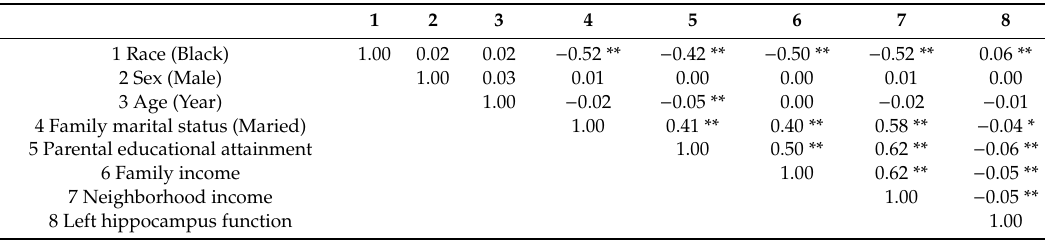
Table 2. Bivariate correlations (n =